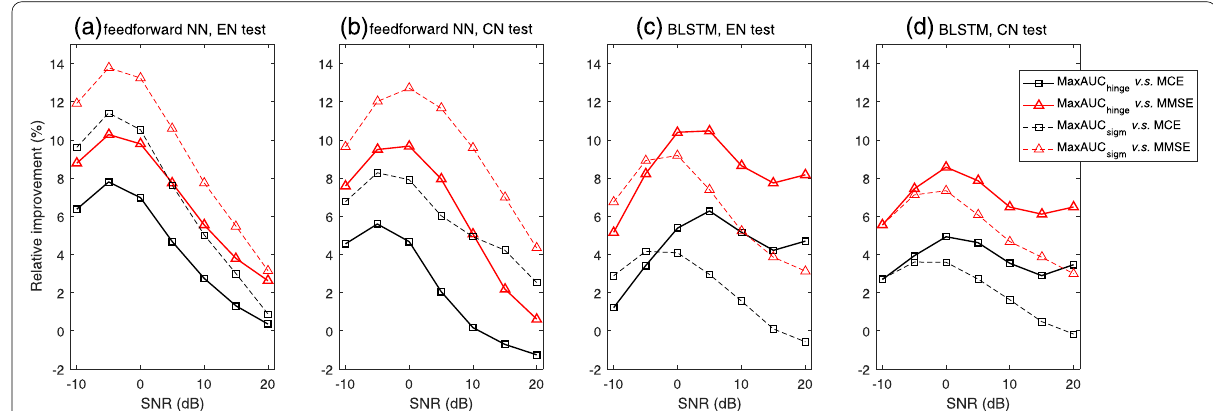
Fig. 2 Relative AUC improvement of the proposed methods over the competitive methods, when STFT is used as the acoustic feature. a Feedforward neural network is used as the basic deep model; the evaluation is conducted on the English Noisy‑CHiME‑4 dataset. b Feedforward neural network is used; the evaluation is conducted on the Chinese Noisy‑THCHS‑30 dataset. c BLSTM is used; the evaluation is conducted on the English Noisy‑CHiME‑4 dataset. d BLSTM is used; the evaluation is conducted on the Chinese Noisy‑THCHS‑30 dataset